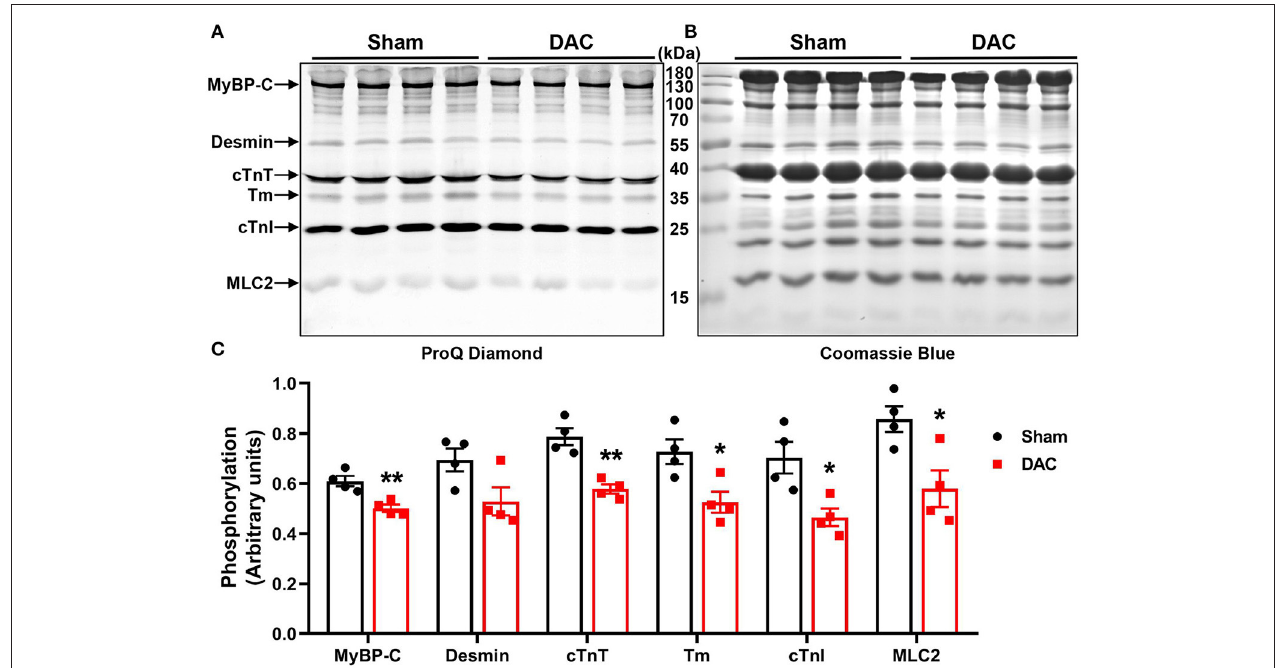
FIGURE 7 | Phosphorylation of contractile proteins. Phosphorylation levels of MyBP-C, desmin, cTnT, tropomyosin (Tm), cTnI, and MLC2 were significantly suppressed (A,C) in minipigs with HFpEF induced by chronic pressure overload. (A) Pro-Q phosphorylation staining image, each band represents an individual animal. n = 4 minipigs per group. * P < 0.05, ** P < 0.01 vs. the sham